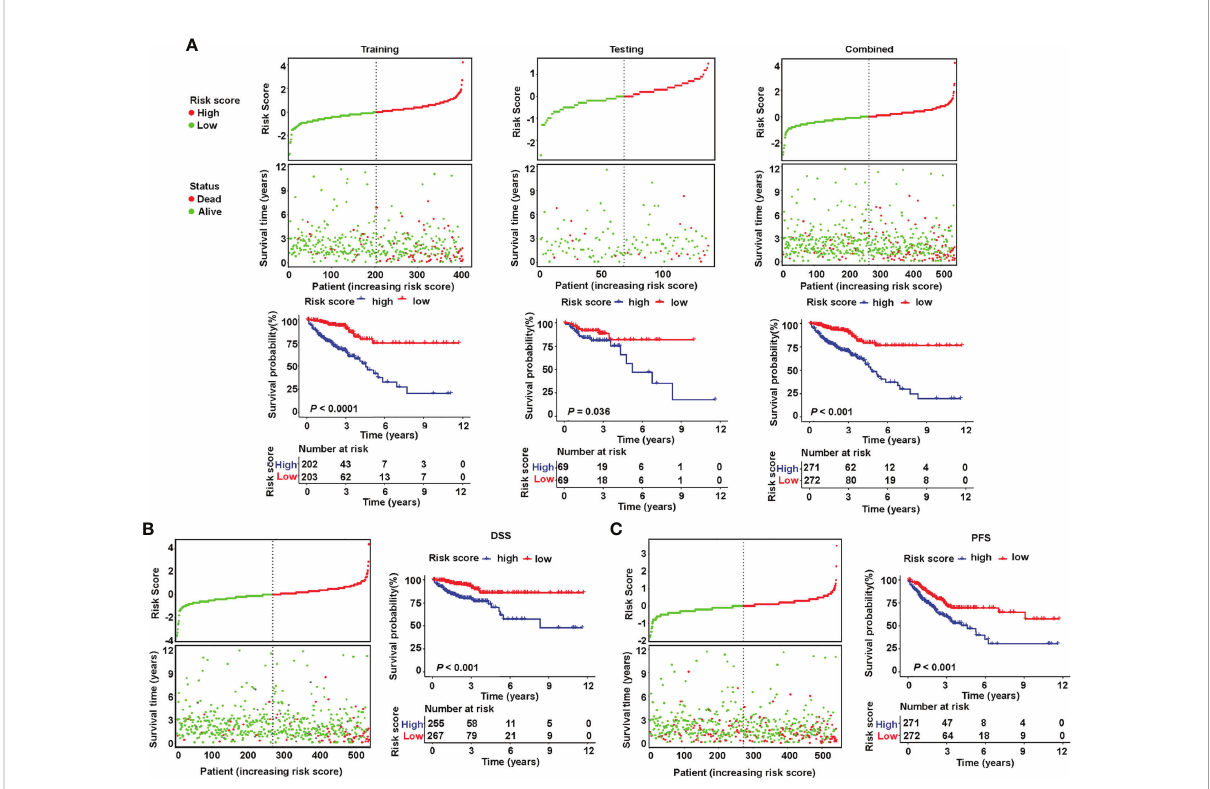
FIGURE 3 Validation of the prognostic value of the sialylation-related lncRNA signature in TCGA. (A) Distribution of risk score (high or low) and status (dead or alive) and KM curves of OS in the training (left), testing (medium), and combined (right) sets. (B, C) Distribution of risk score and status and KM curves of DSS and PFS in the combined set. KM, Kaplan-Meier survival test; OS, overall survival; DSS, disease-speci fi c survival; and PFS, progression-free